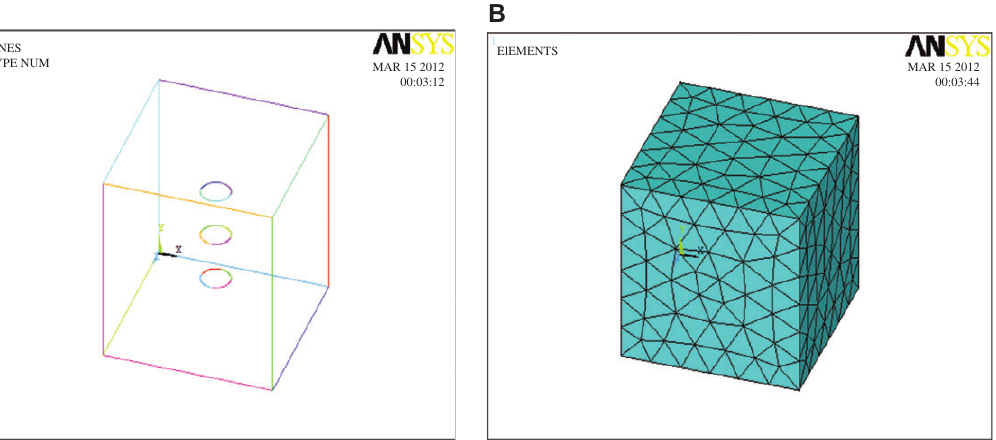
Figure 1 (A) Schematic model of 4 wt.- % particulate-filled A384 alloy composites. (B) Mesh pattern model for particulate-filled A384 alloy